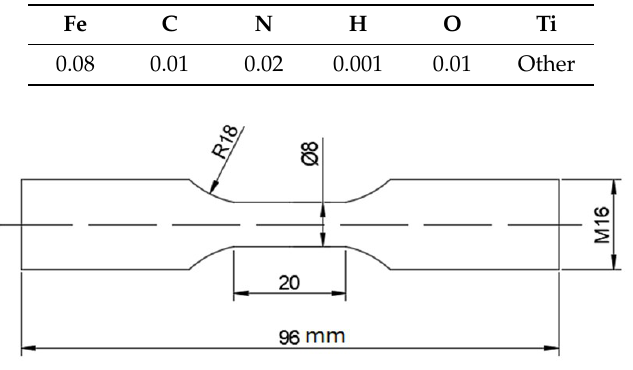
Table 1. Chemical composition of commercial pure titanium (CP-Ti) (weight %).